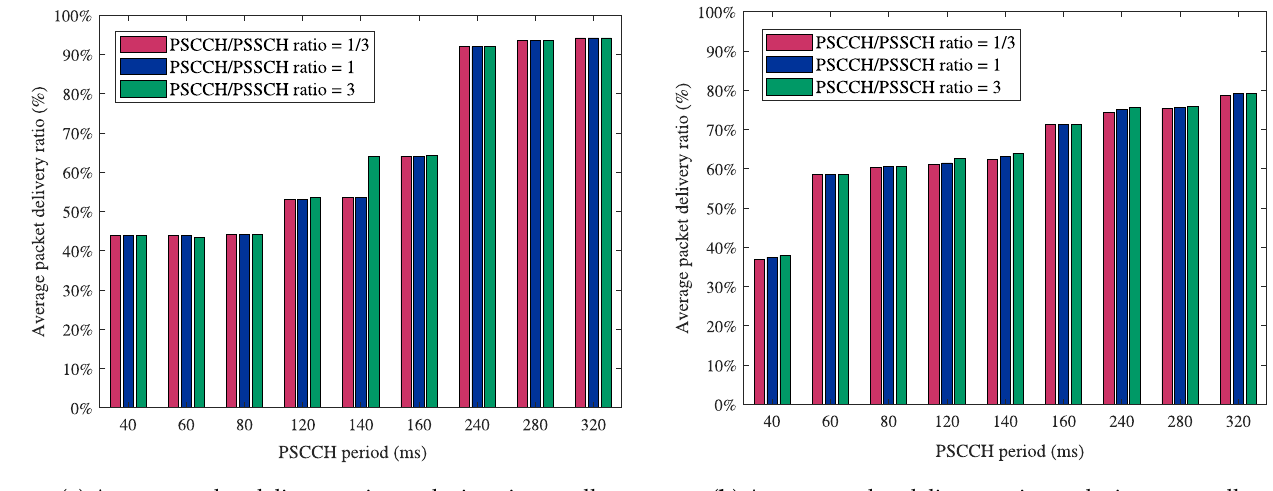
Figure 6. Impact of the PSCCH period and the PSCCH/PSSCH ratio on reliability performance in MCPTT calls.